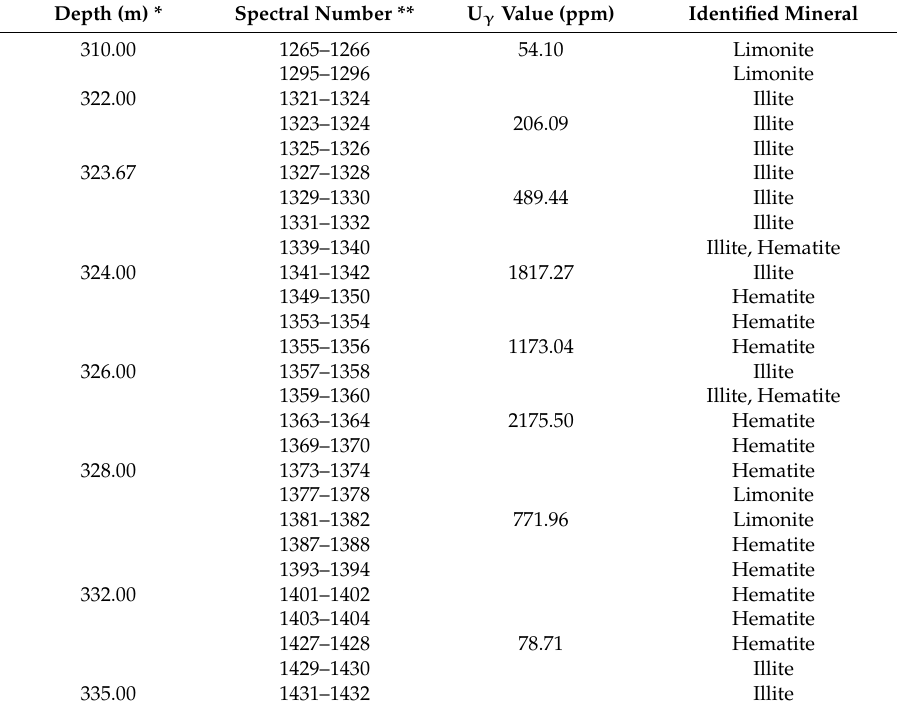
Table 2. Spectra and U γ values of the drill hole